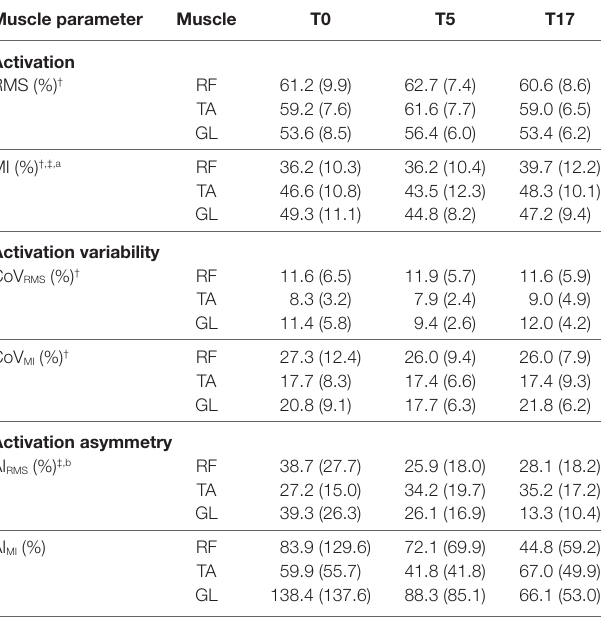
TaBle 3 | Muscle activation root mean square and modulation index (RMS, MI), muscle activation variability (CoV RMS , CoV MI ), and muscle activation